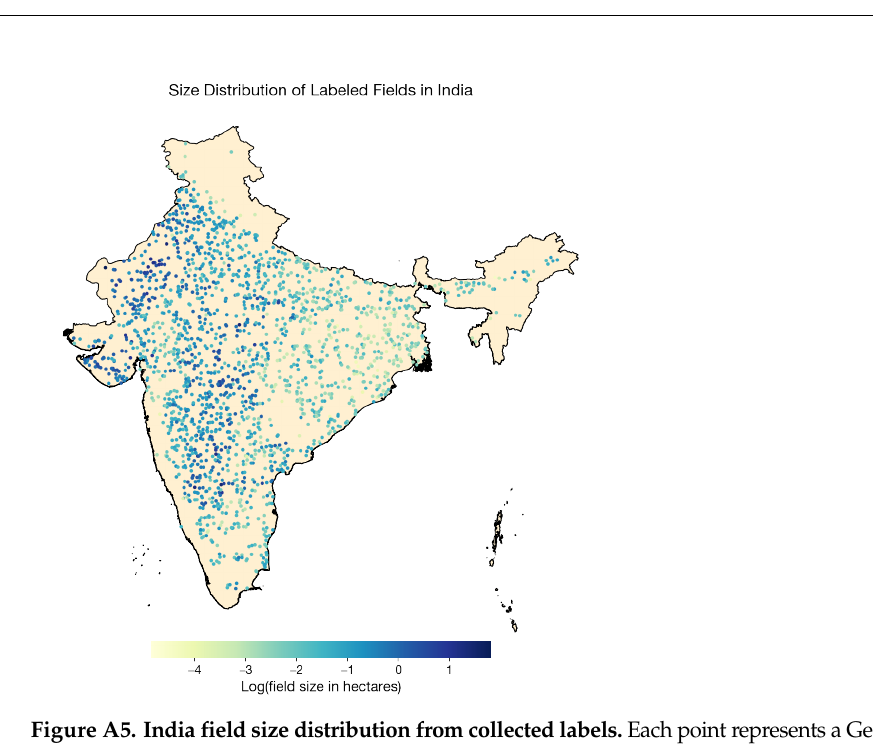
Figure A5. India field size distribution from collected labels. Each point represents a Geo-Wiki location where five field labels were collected. The average field size in each image is plotted on a log scale.